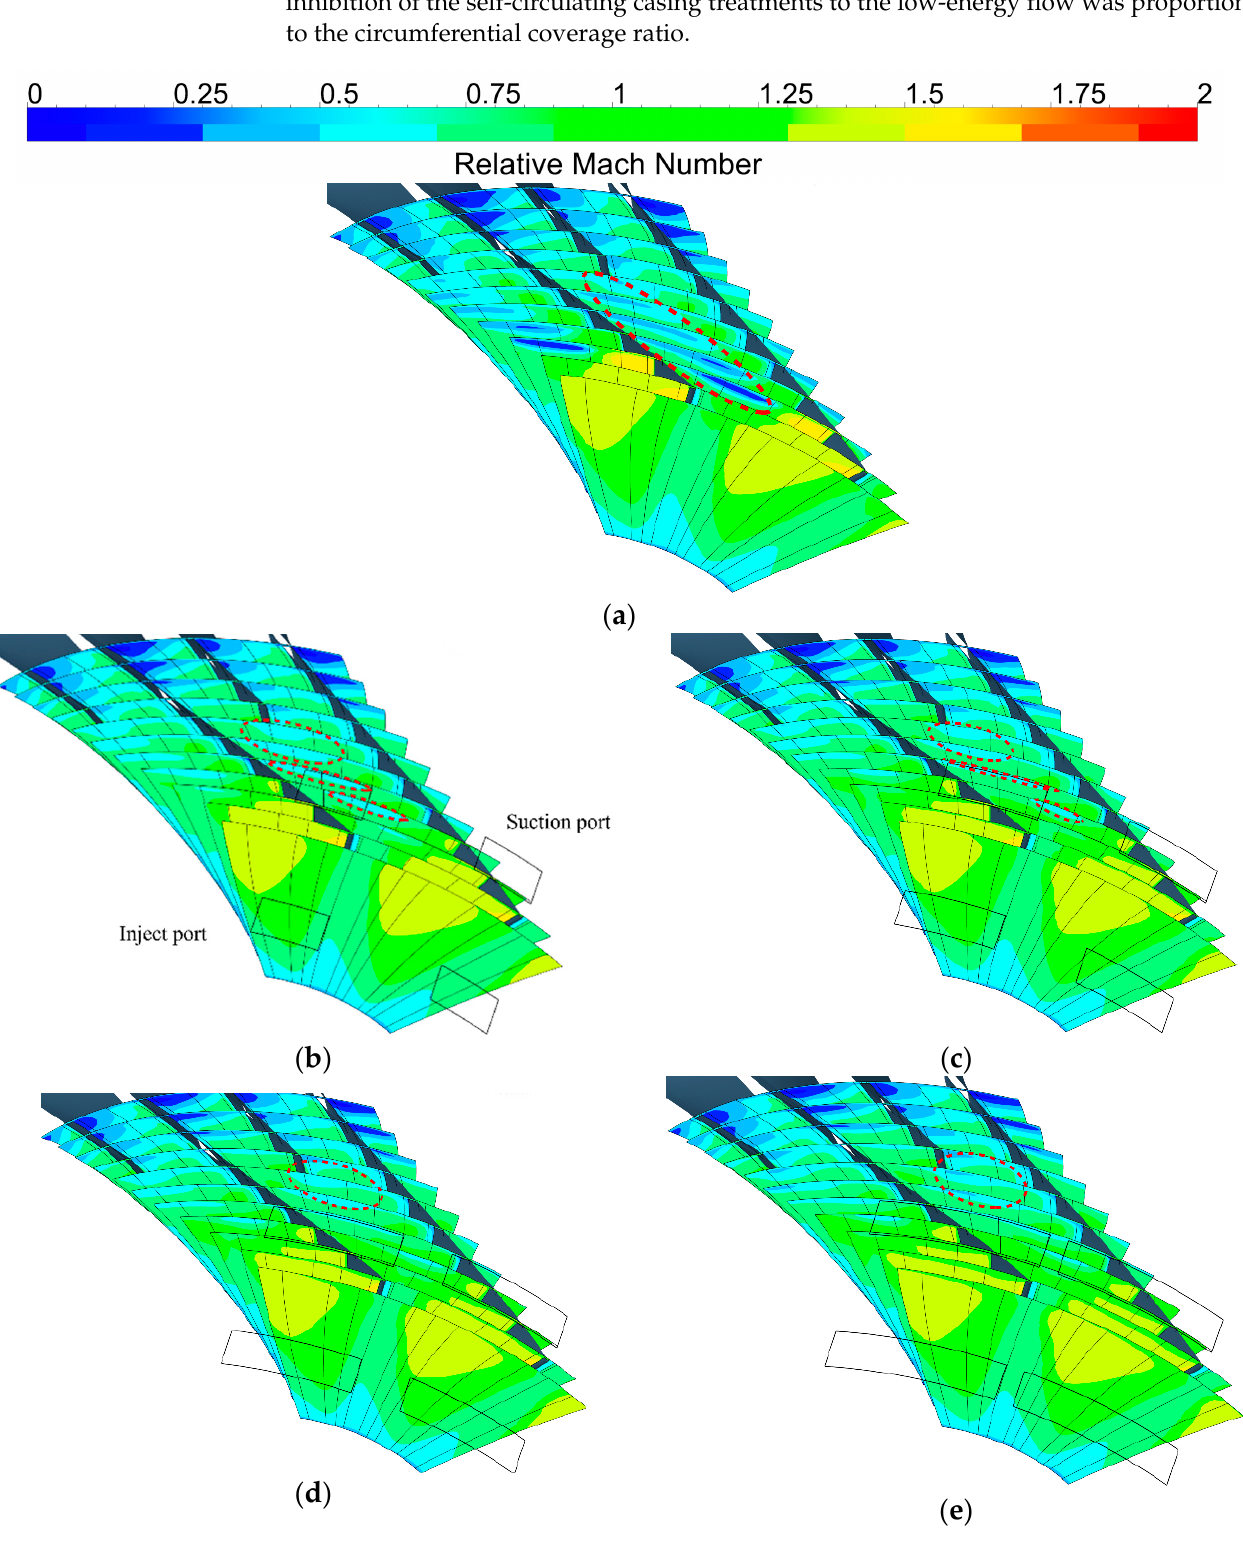
Figure 12. Relative Mach number distribution in the blade tip passage. ( a ) SW. ( b ) SRCC0.36. ( c ) SRCC0.54. ( d ) SRCC0.72. ( e ) SRCC0.9.